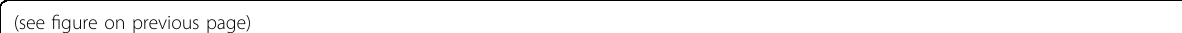
Fig. 2 TLR2 and TLR4 are NCL receptors. A The NF κ B luciferase assay. TLR4, MD2 and CD14 collectively respond to LPS. TLR2 often dimerizes with TLR1, TLR6 or TLR10 to respond to its ligands. After ligand binding, most TLRs recruit MyD88 to activate NF- κ B and other signaling pathways. In this assay, TLRs and two luciferase reporters, i.e., p5xNF κ B-Luc and pRL-CMV, were co-expressed in 293T cells. After TLR ligand stimulation, NF κ B-directed luciferase expression was measured. B Roles of MyD88 and caspase-1 in PBMC response to NCL. PBMC were pre-treated with the MyD88 inhibitor st- 2825 (30 μ M), the caspase-1 inhibitor Ac-YVAD (10 μ M), or both. Cells were then stimulated with plate-coated NCL or, as controls, plate-coated HMGB1 (40 μ g/ml) or soluble LPS (10 ng/ml). TNF α and IL-1 β were measured by ELISA. C , D NCL and HMGB1 activation of TLR signaling. TLR2, TLR4 or TLR5 was each co-expressed with their co-receptors and the luciferase reporters and then stimulated with coated NCL or HMGB1 (40 μ g/ml) or soluble LPS (0.5 μ g/ml). TLR activation was measured based on NF κ B-directed fi re fl y luciferase expression, which was normalized to CMV-directed Renilla luciferase expression in each well. Triplicate experiments were performed to obtain data as mean ± SD, which were analyzed by one-way ANOVA. * p < 0.05, ** p < 0.01, *** p < 0.001, **** p < 0.0001. E Roles of TLR2, TLR4 and TLR5 in monocyte response to NCL, HMGB1 and LPS. Monocytes were pre-incubated with TLR2, TLR4, or TLR5-blocking antibodies before stimulation with coated NCL, coated HMGB1 or soluble microbial ligands for TLR2 (LTA,10 μ g/ml), TLR4 (LPS, 10 ng/ml), or TLR5 ( fl agellin, 1 μ g/ml). Triplicate experiments were performed and TNF α production was measured. Data were analyzed by student t -test. * p < 0.05, ** p < 0.01, *** p < 0.001, **** p <